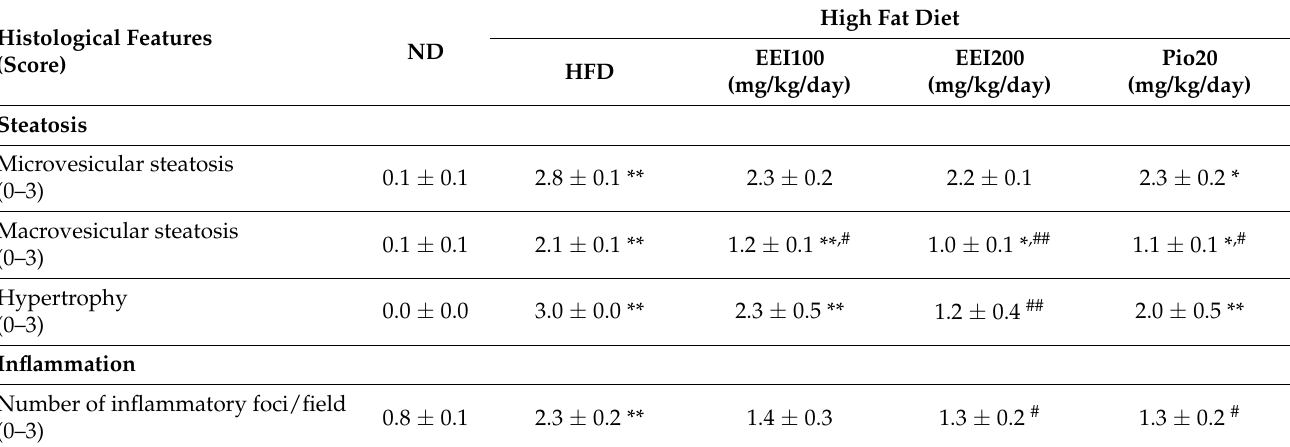
Table 4. The effect of 2-week feeding EEI on the histopathological score of liver tissue.